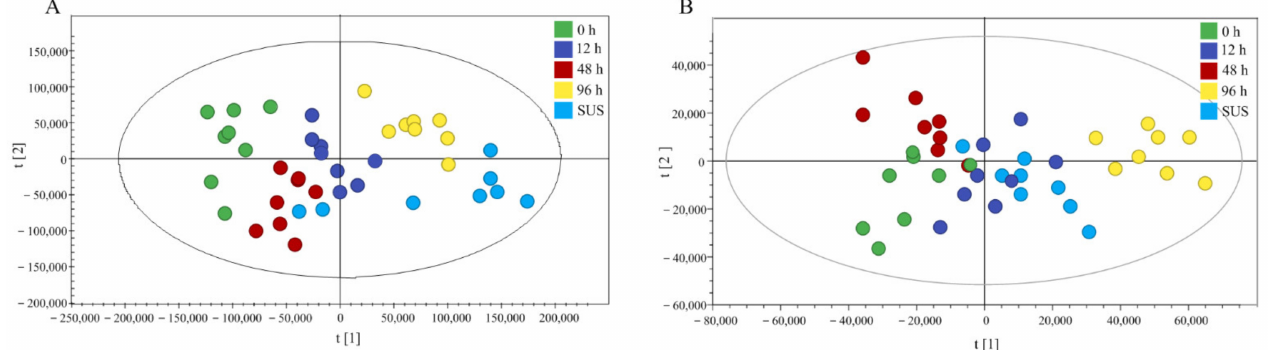
Figure 5. Principal component analysis score scatter plot in ESI + ( A ) and ESI − ( B ) modes for the total lipids in the gut of different groups of A. japonicus after V. splendidus